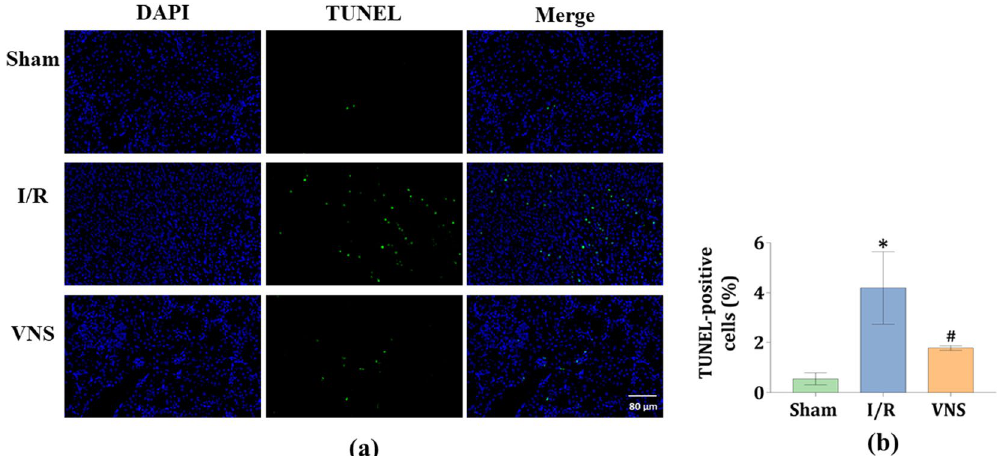
Figure 5. VNS reduces cell apoptosis in kidneys after hepatic I/R injury. ( a ) Representative micrographs of immunofluorescence staining for DAPI (blue) and TUNEL (green) in kidney cell nuclei from the three groups are shown. ( b ) Quantification of kidney cell apoptosis from the three groups is shown. *p < 0.05 vs. the Sham group; # p < 0.05 vs. the I/R group. Fluorescence microscope (× 400 magnification).